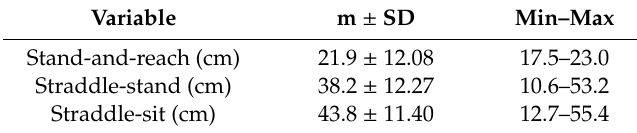
Table 1. Descriptive statistics of classic tests for 7b–8c redpoint (RP) climbers ( n =